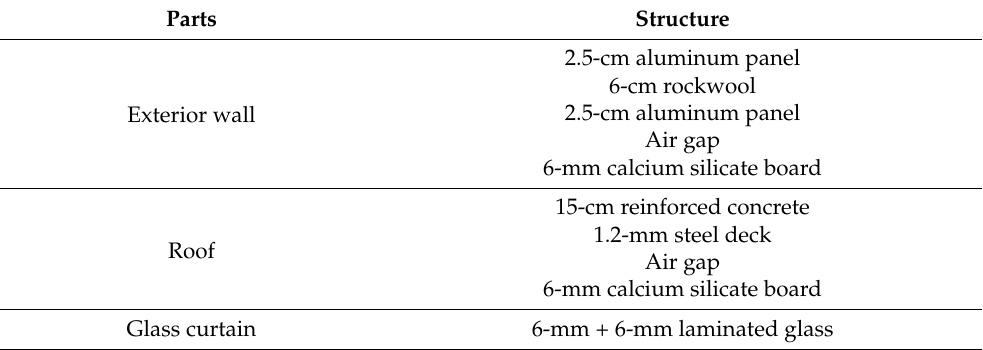
Figure 4. ( a ) Exterior and ( b ) interior of SPINLab. Table 1. The structure of SPINLab.